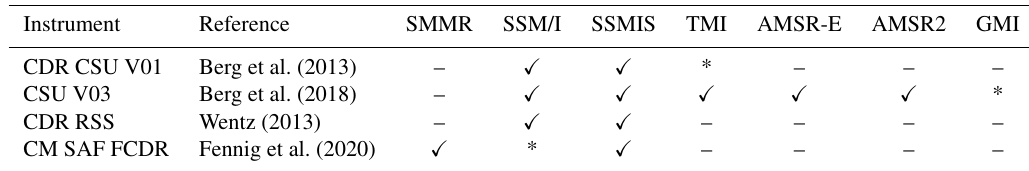
Table 1. The characteristics of the available fundamental climate data records from passive microwave imagers. The (cid:88) denotes an inter- calibrated instrument, while the ∗ is for the reference